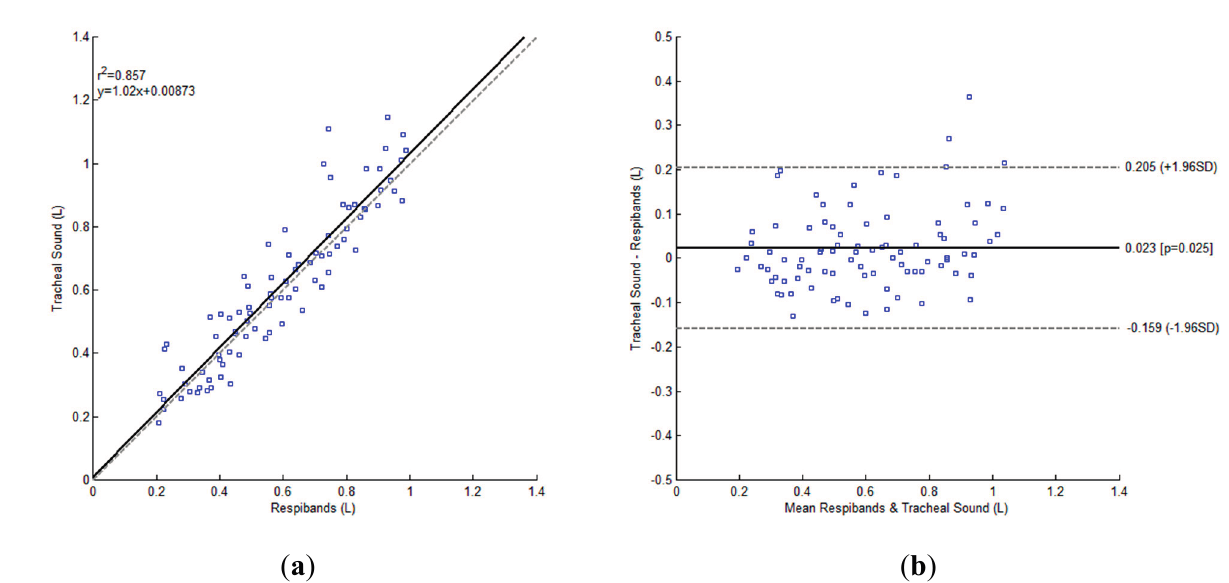
Figure 8. Bland-Altman plot for BFD feature with the exponential model, for expiratory phase, while the participants ( N = 5) were breathing without a tube during the first day of experiments. ( a ) The regression plot: The unitary line is shown as gray dashed line, while the regression line is represented as black solid line; ( b ) Bland-Altman plot: The bias is represented as a solid black line and the 95% limits of agreement as gray dashed